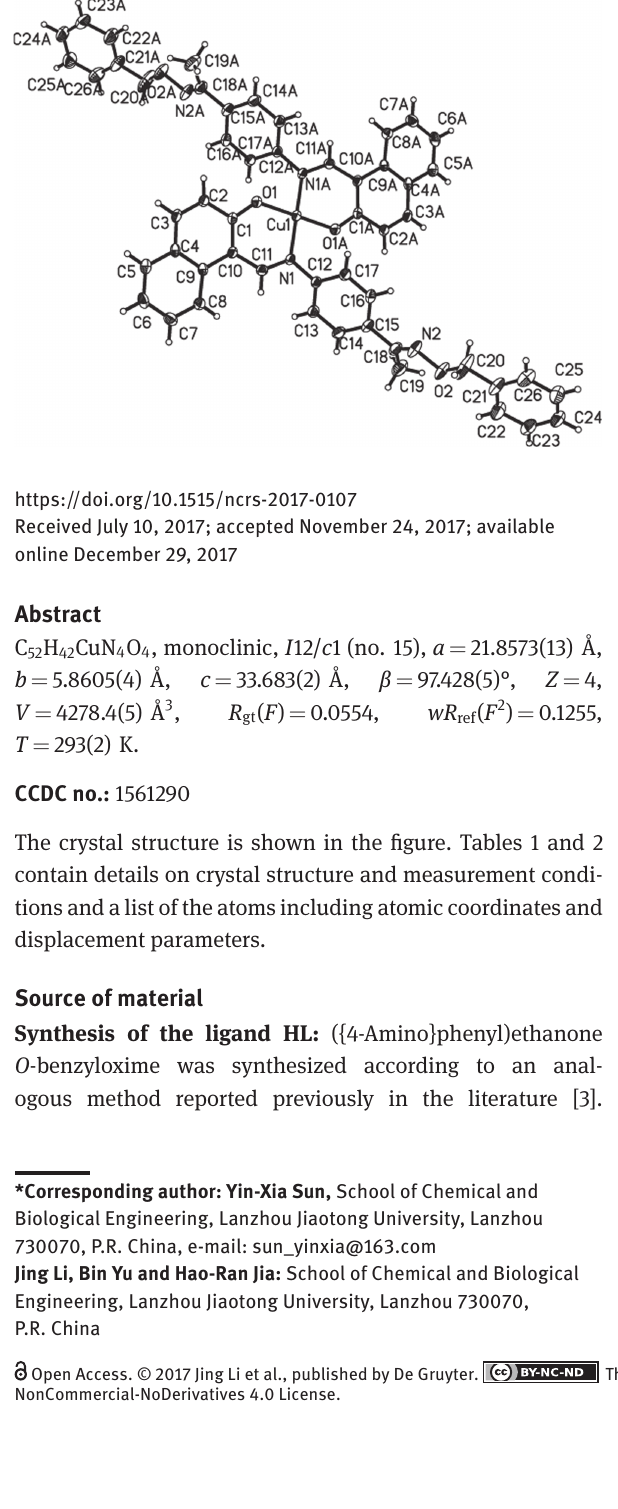
Table 1: Data collection and handling.